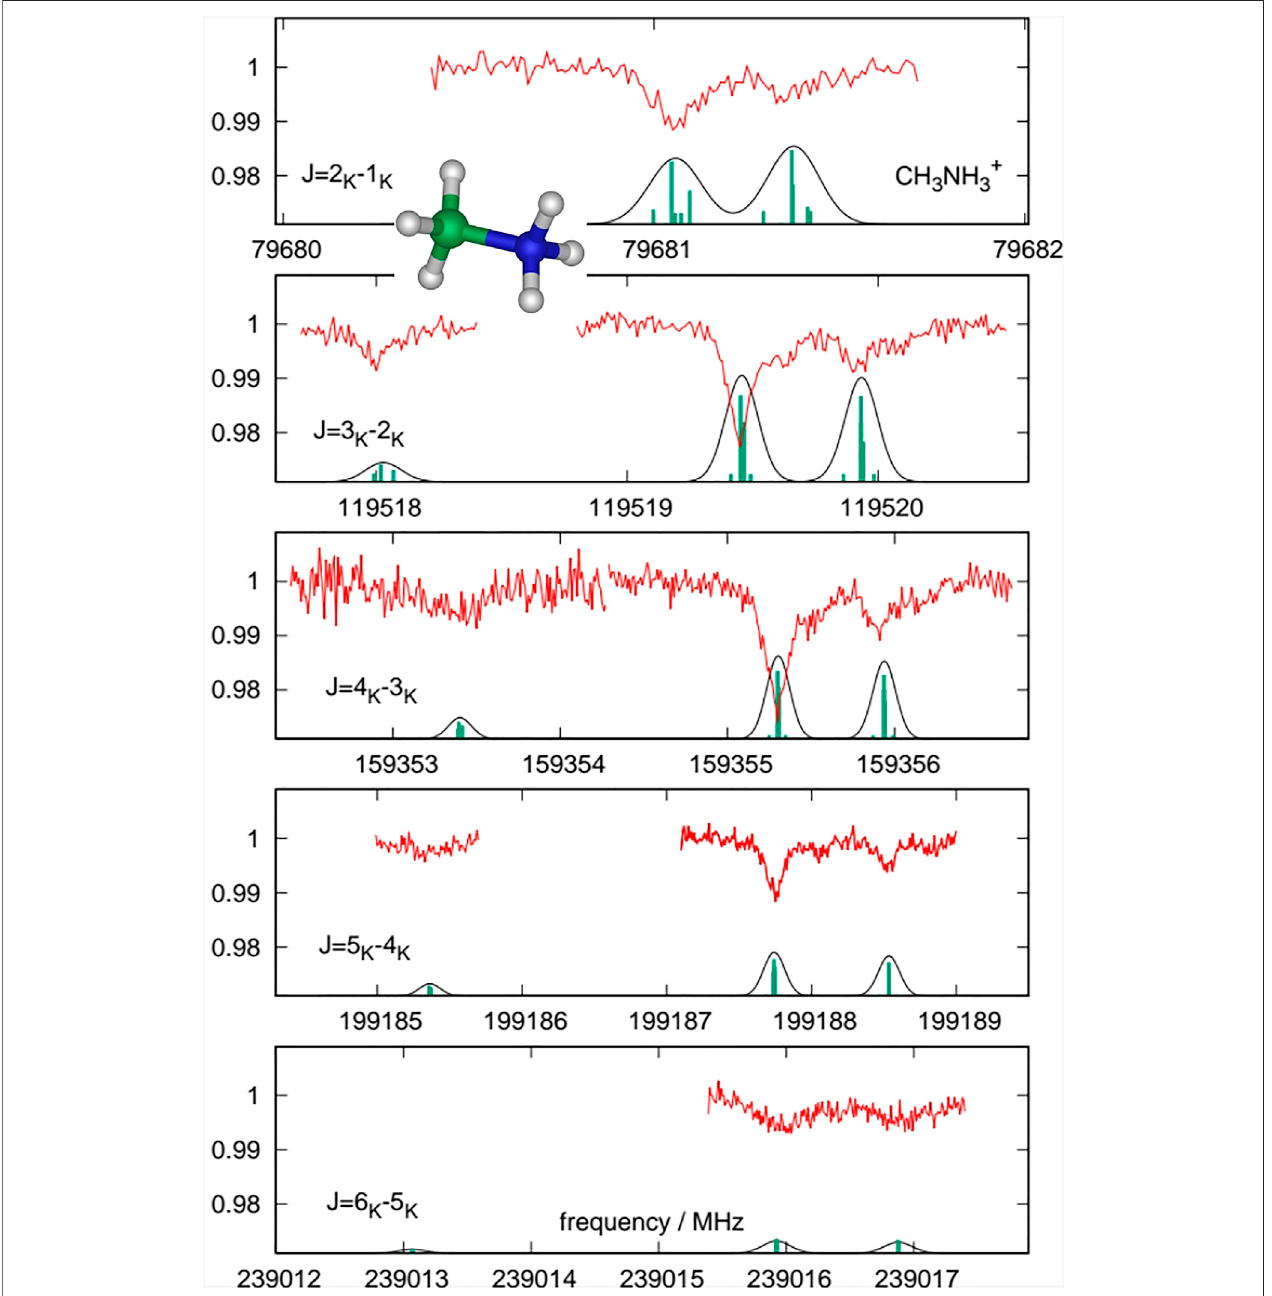
FIGURE 1 | Measurements of the J K ′ ← J K ″ ( K (cid:2) 0, 1, 2) rotational transitions of CH 3 NH 3 + (red trace), recorded as depletion signal of the normalized CH 3 NH 3 + − He counts.Thesimulations(greensticksindicatenitrogenquadrupolehyper fi nestructure(hfs)andtheirconvolutionisgivenasblacktraces),basedonasymmetricrotormodel ( Table 1 , fi t I), indicate that the hyper fi ne splitting is not resolved and that discrepancies between the simulated and measured spectra, in particular the blue-shifted shoulders for K (cid:2) 0 and 1 (red trace), are most probably due to the neglect of torsional motion in the simulation.